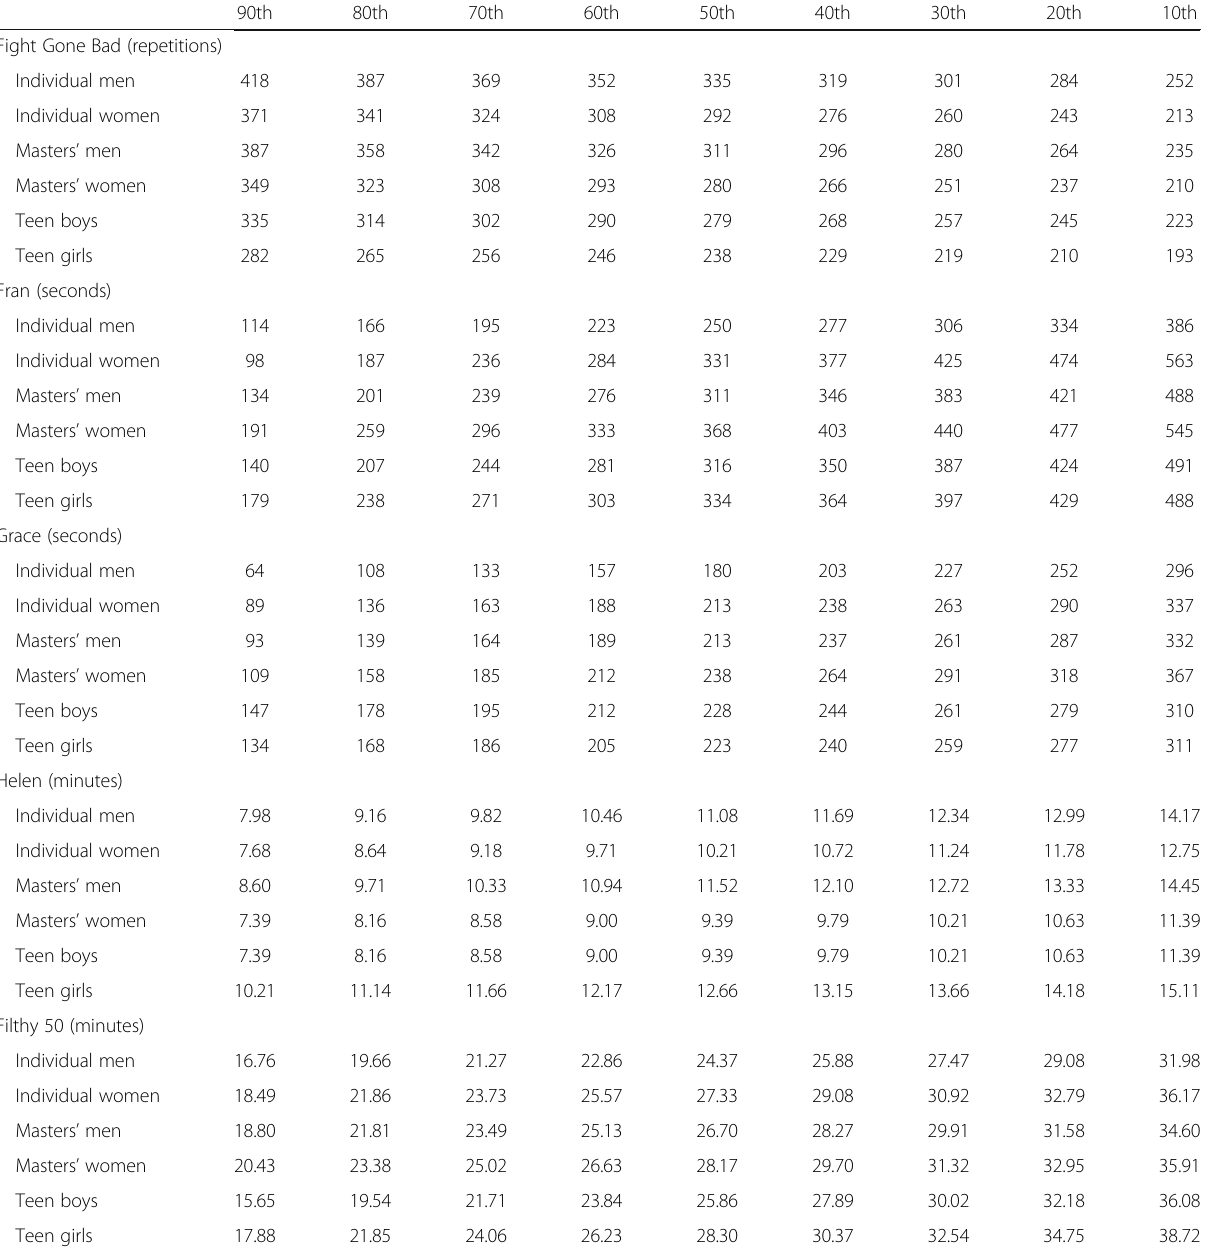
Table 2 Percentile ranking scores for competitive age classifications and sex in common benchmark